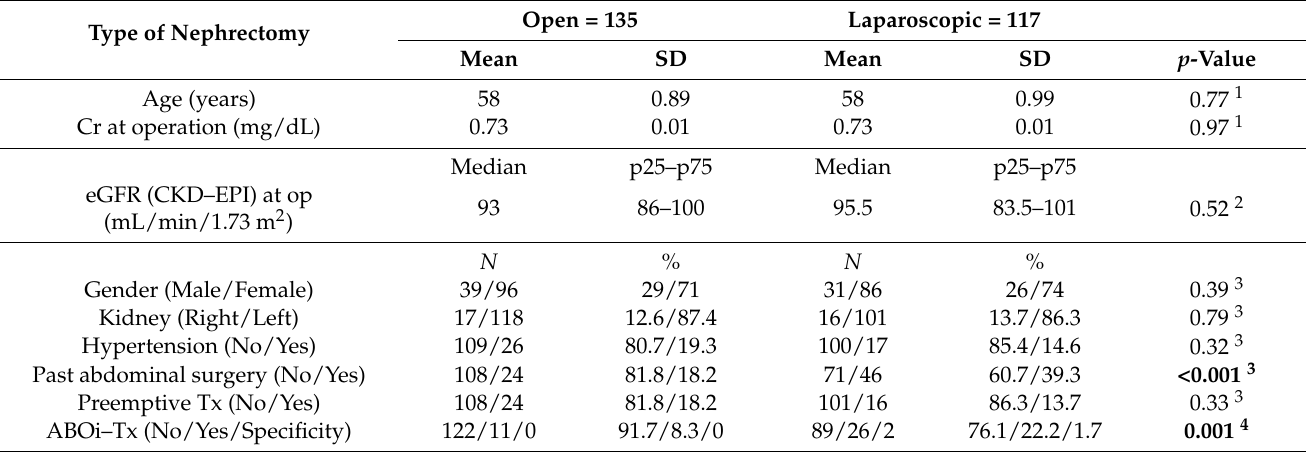
Table 1. Patient characteristics.